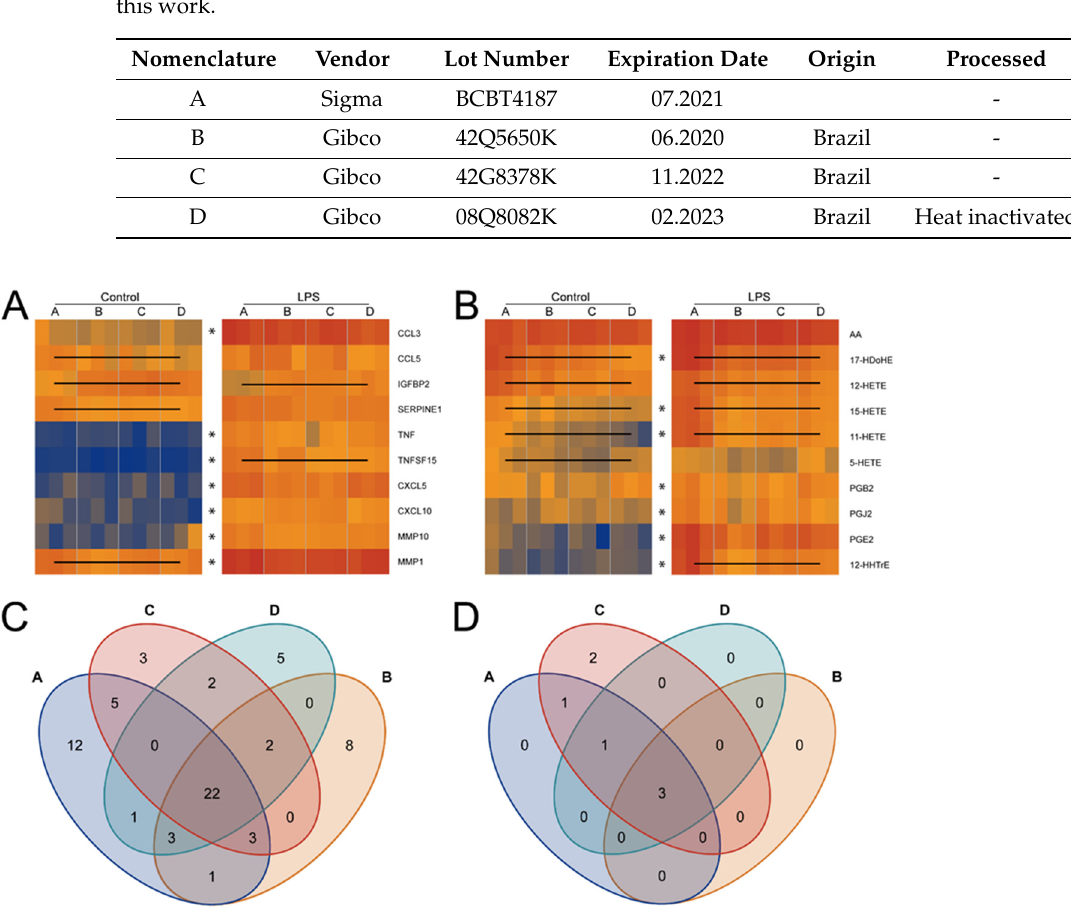
Figure 1. Heatmaps of selected proteins ( A ) and eicosanoids ( B ) determined in secretomes of control and LPS-treated U937 cells cultured with the indicated batch of FCS, A, B, C or D. Lines within a heatmap indicate a significant difference of the given molecule within at least two batches. Asterisks (*) indicate that LPS-treatment induced a significant increase. Venn diagrams of significantly up- and downregulated ( C ) proteins (S0 = 2, FDR = 0.01) and ( D ) eicosanoids comparing LPS activation with control samples for all four FCS batches ( A – D ).